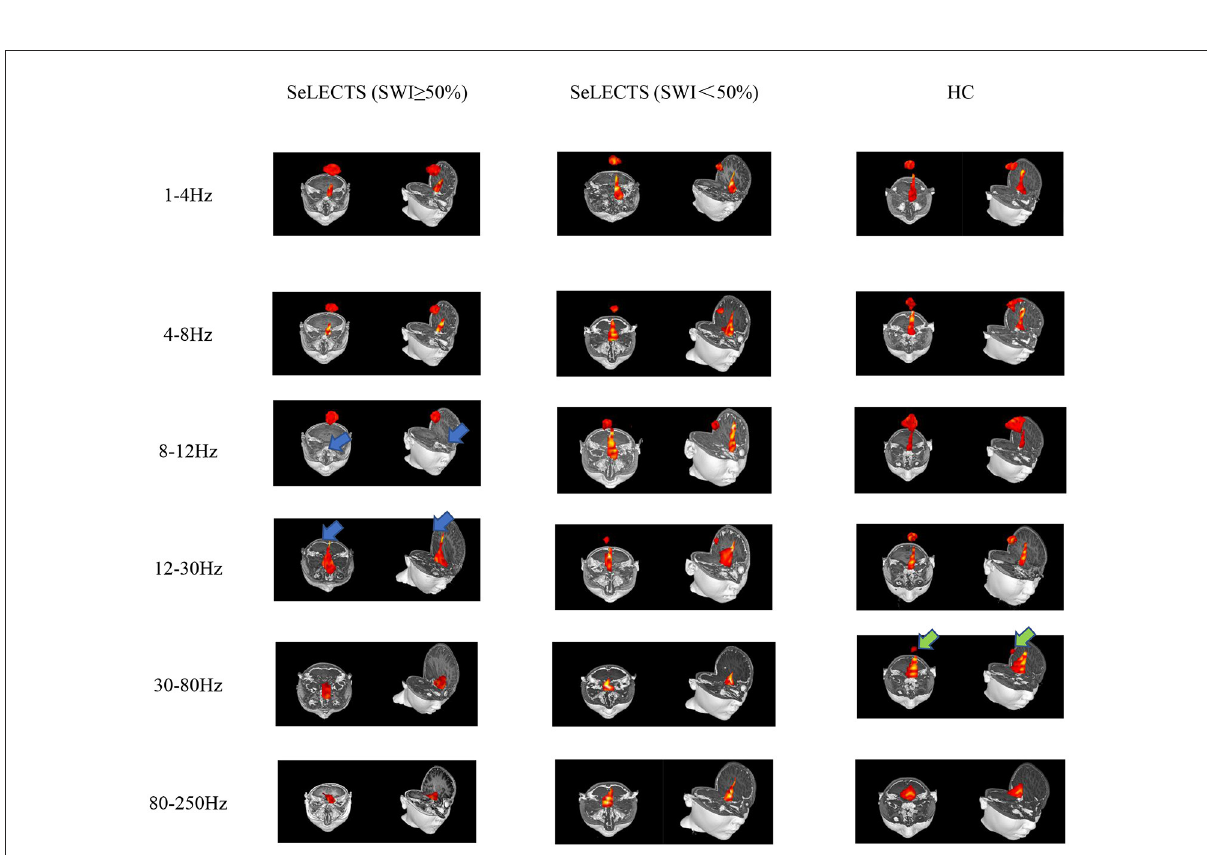
FIGURE2 Typical magnetic source localization in the frequency band of 1–250Hz for three groups of subjects. In the 8–12 and 12–30Hz frequency bands, the SeLECTS (SWI ≥ 50%) group was inactivated in the PCC region, as indicated by the blue arrows. In the 30–80Hz band, the HC group is activated in the PCC region as shown by the green